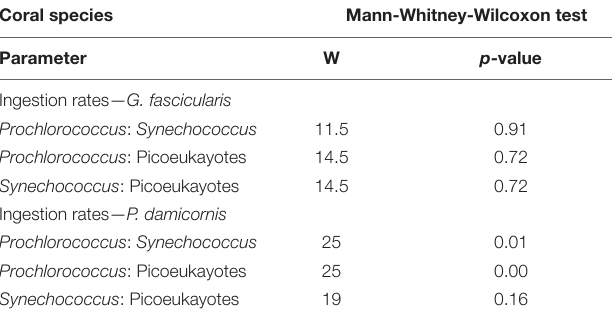
TABLE 2 | Summary of statistical analyses performed with the non-parametric test Mann-Whitney-Wilcoxon test for picoplankton ingestion rates between coral